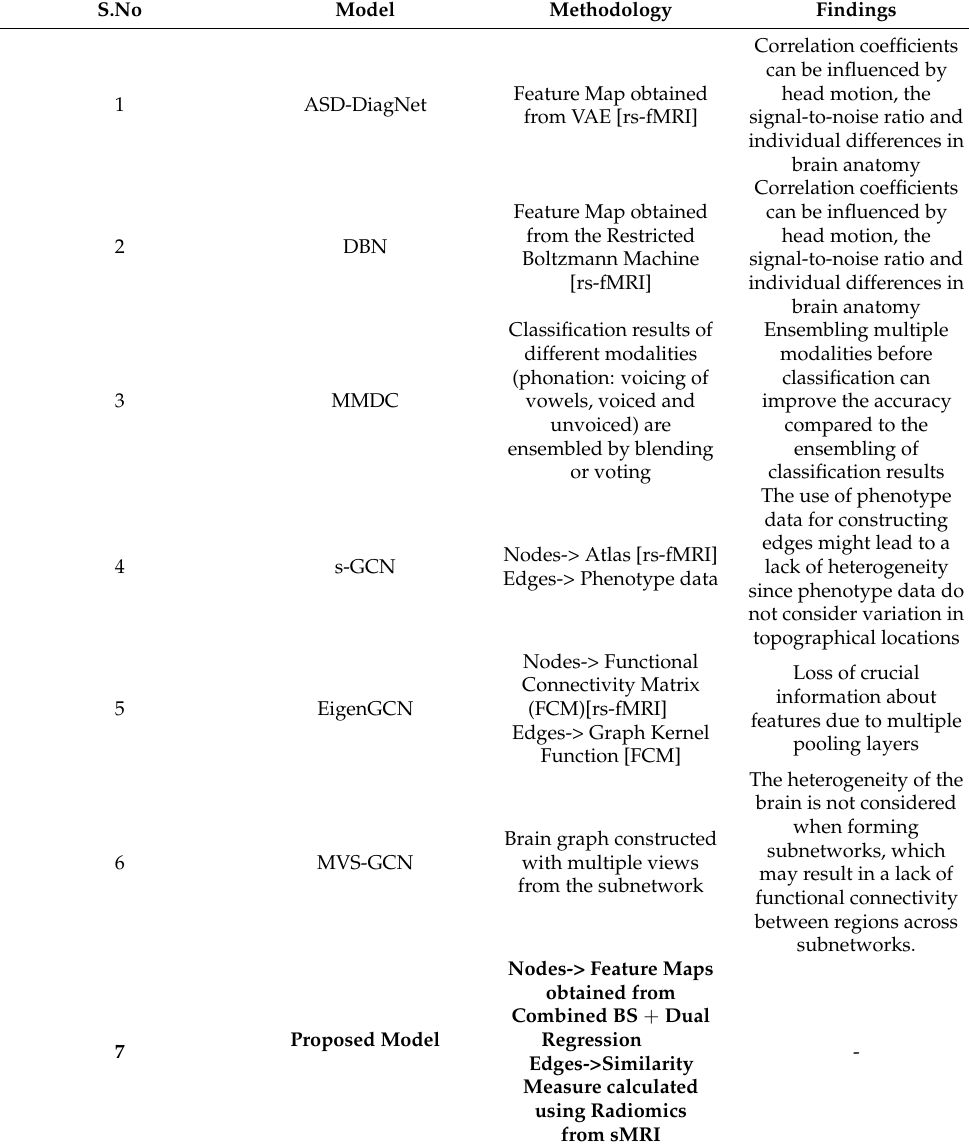
Table 2. Comparison of Proposed Model with Recent Similar